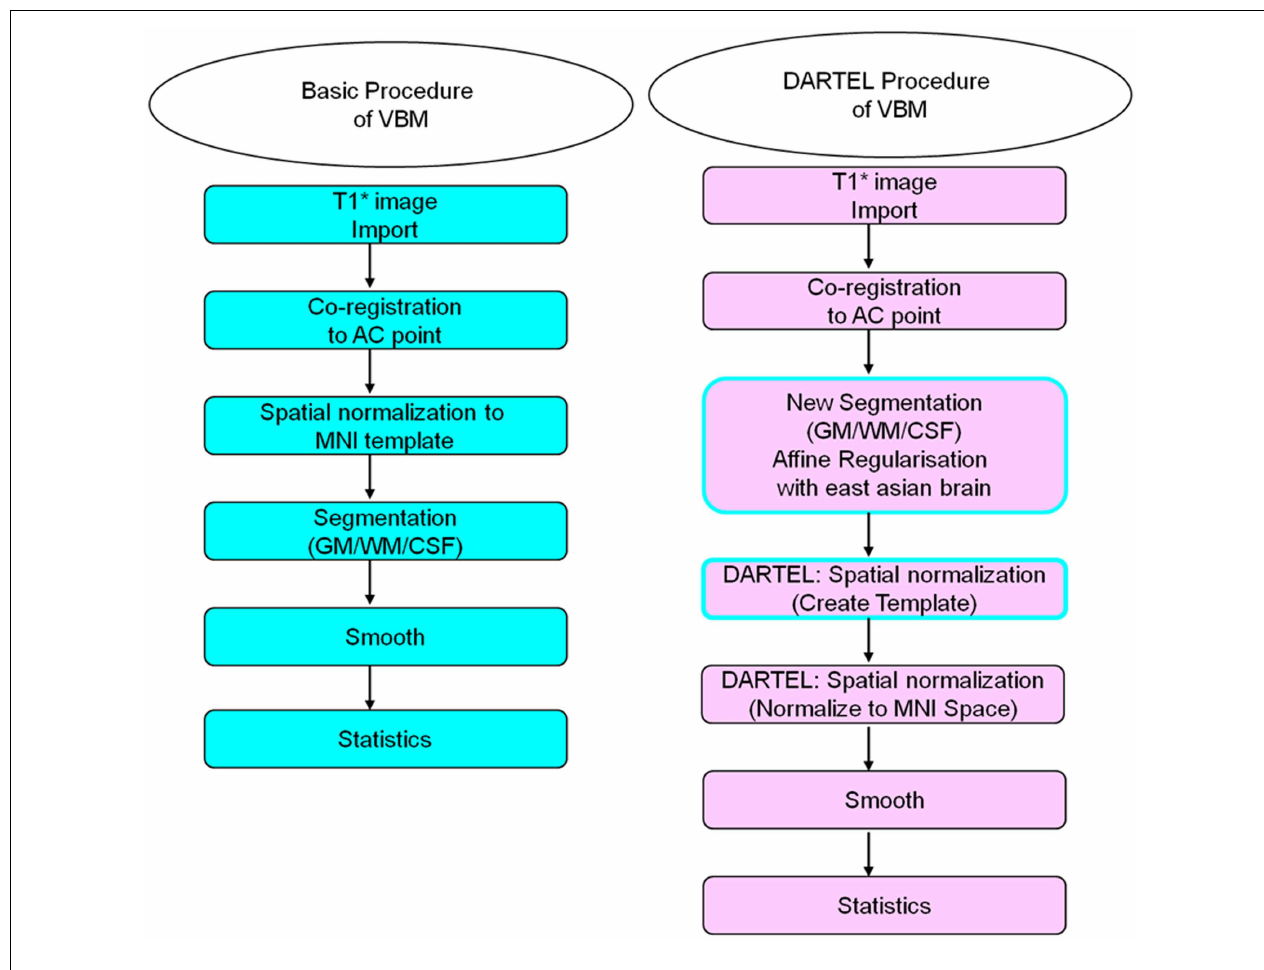
and correct AC point) of DARTELVBM is as same as that of basicVBM. However, the DARTELVBM method launched a new segmentation processing first, in an affine regularization with East Asian brain. Furthermore, the DARTELVBM method also provided a function to create a template by integrating the sampled subjects’ brain for spatial normalization and finally normalized to the MNI template for position localization.The other image-processing step and statistical testing were similar to the basicVBM